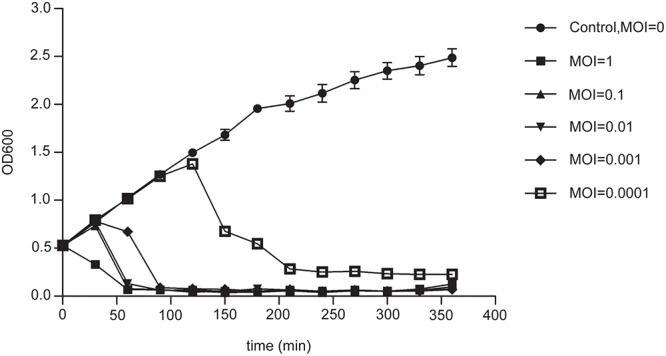
The infection assay of phage PD-6A3 against A. baumannii in vitro. AB32 was infected by phage PD6A3 at MOI of 0, 1, 0.1, 0.01, 0.001 or 0.0001 and cultured for 7 h. The control experiments were performed using equal volume of SM buffer. This experiment was repeated three times, and the data were shown in the mean ± SD. PD-6A3, a novel Acinetobacter baumannii Phage.